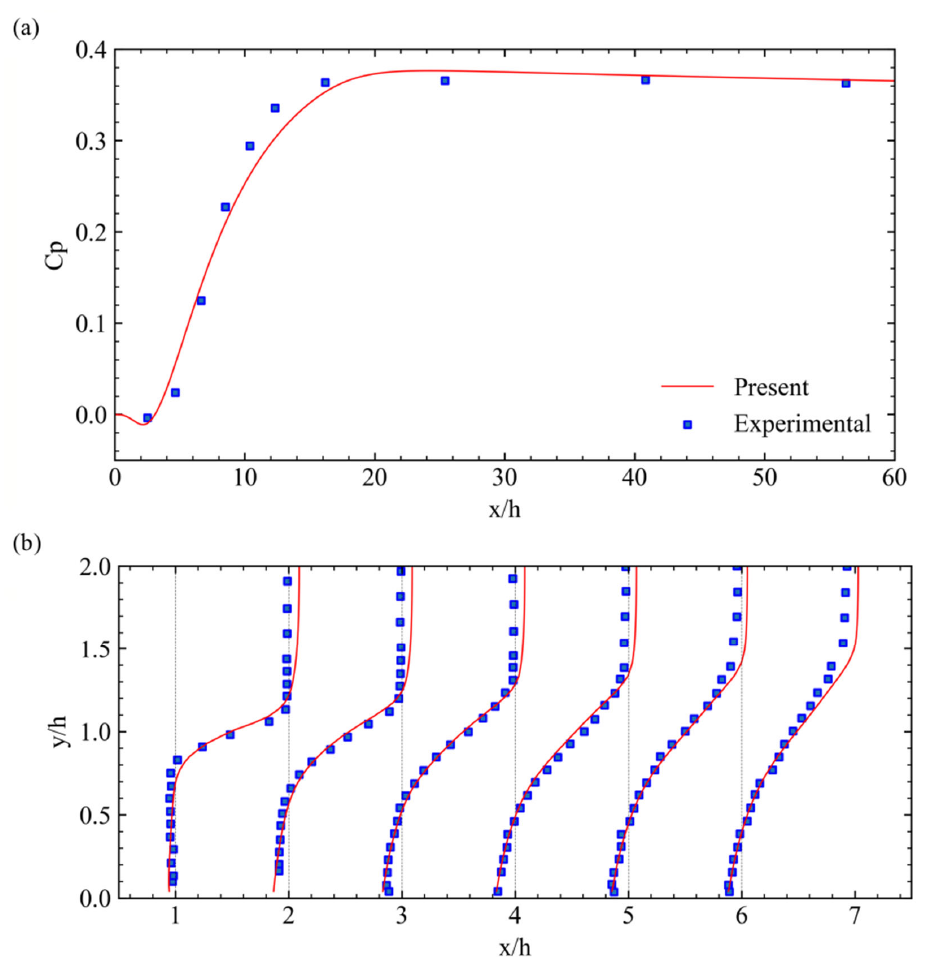
Figure 6. ( a ) Variation of the pressure coefficient and ( b ) velocity profiles 𝑢 / 𝑈 (cid:2868) along the channel.